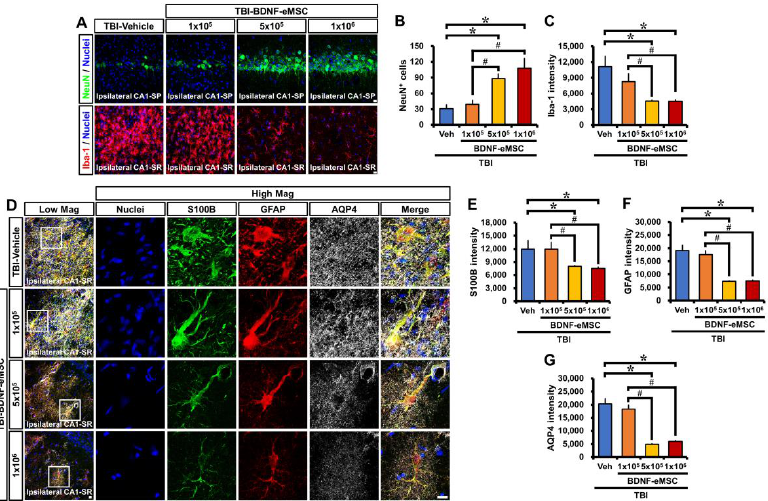
Figure 4. A single administration of BDNF-eMSCs reduces neuronal death and glial activation after TBI. ( A ) Representative images showing the expression of NeuN (green) or Iba-1 (red) in the CA1 stratum pyramidal (SP) or stratum radiatum (SR) of the ipsilateral hippocampus 14 days after TBI, respectively. Scale bar, 10 µ m. ( B , C ) Quantification of the number of NeuN + neurons ( B ) or immunofluorescence intensity of Iba-1 ( C ), as determined in the CA1 SP or SR of the ipsilateral hippocampus after TBI, respectively. Data are mean ± SEM; n = 4 per group. * p < 0.05 vs. vehicle-treated TBI group; # p < 0.05 vs. BDNF-eMSCs (1 × 10 5 )-treated TBI group (Kruskal–Wallis test followed by Bonferroni post hoc test: ( B ): Chi-square = 11.691, df = 3, p = 0.009; ( C ): Chi-square = 8.846, df = 3, p = 0.031). ( D ) Triple-label confocal micrographs of S100 calcium-binding protein B (S100B, green), glial fibrillary acidic protein (GFAP, red), and aquaporin-4 (AQP4, gray) in the CA1 SR